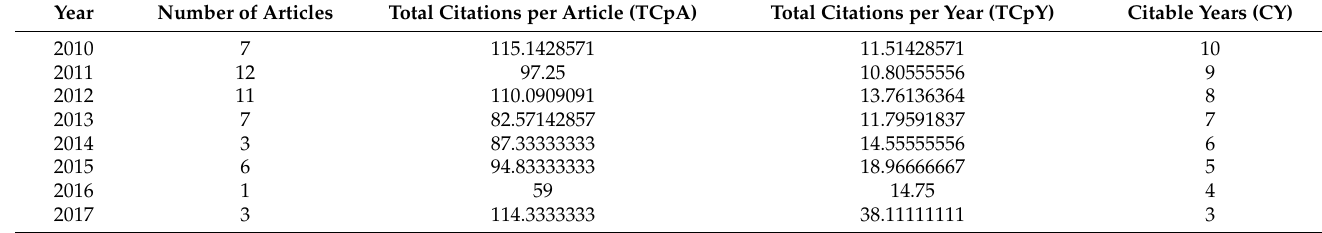
Table 4. Average Citations per Year.